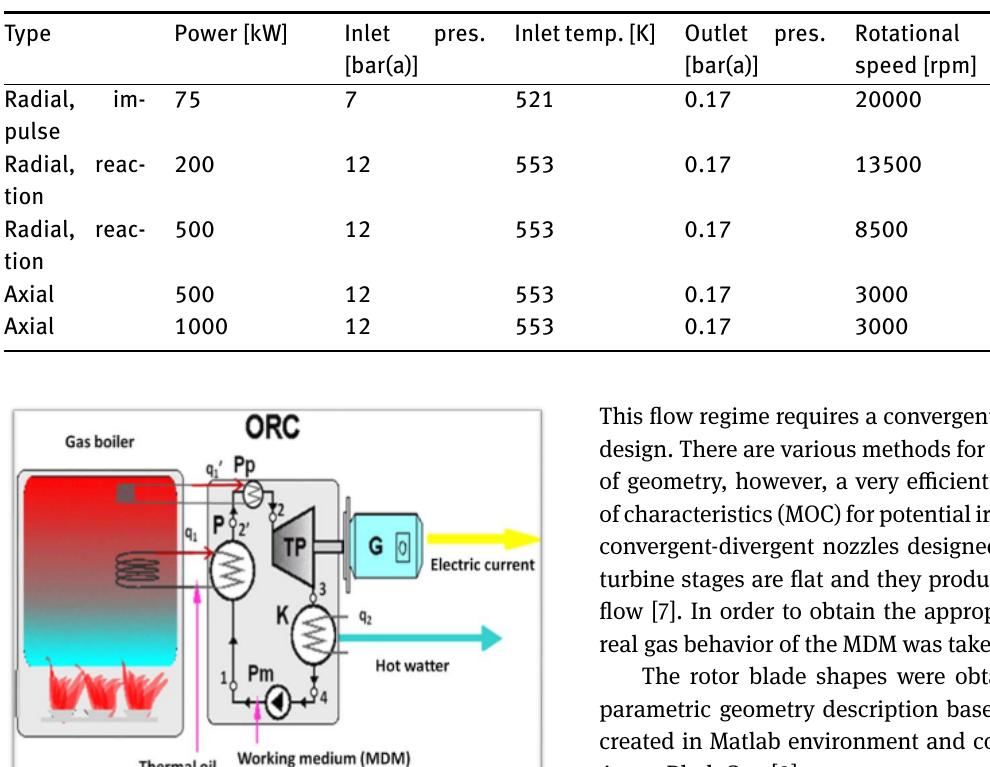
Table 1: The set of turbine configurations.